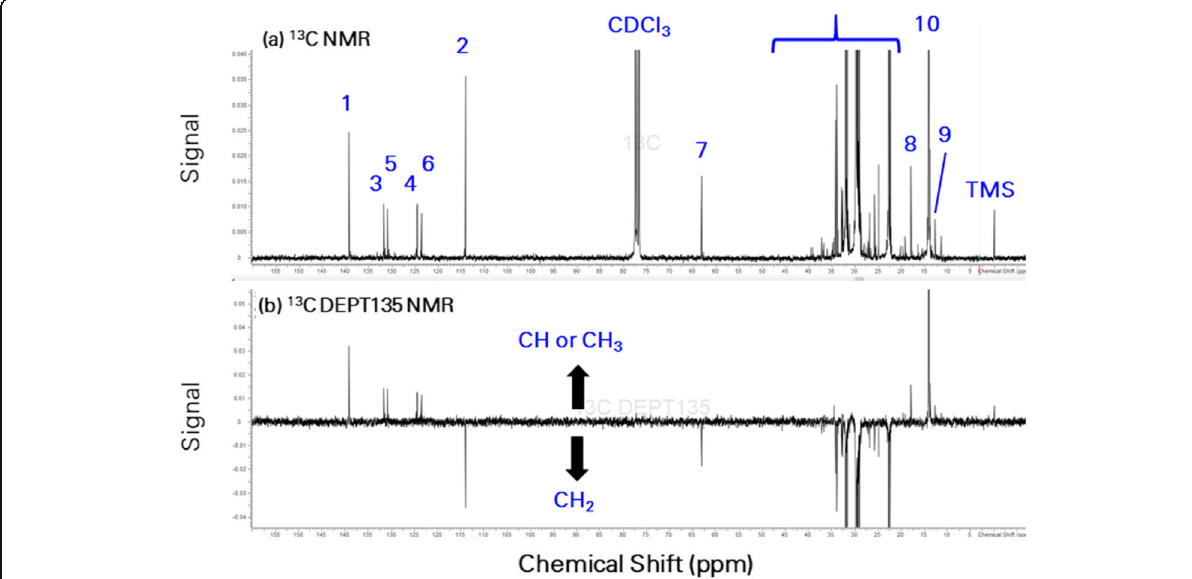
Fig. 11 13 C NMR and 13 C DEPT 135 NMR analysis of LHcL1. a 13 C NMR, 0 to 160ppm range. b 13 C DEPT 135 NMR, 0 to 160ppm